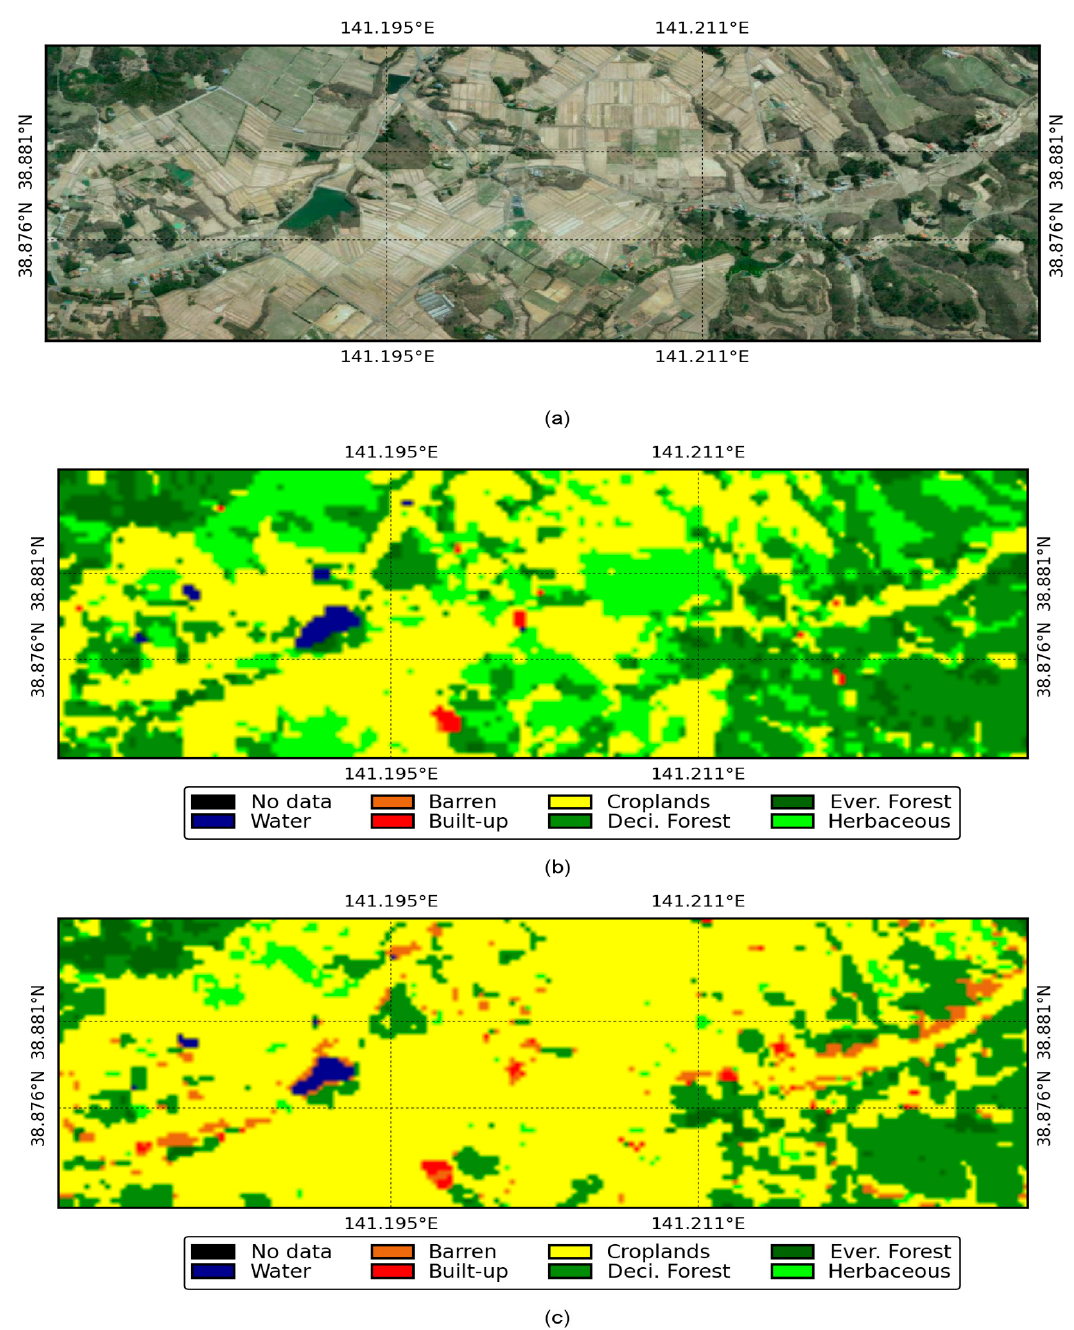
Figure 13. Performance of the JpLC-30 map over the JHR LULC map: ( a ) Google Earth™ image; ( b ) JHR LULC map; ( c ) JpLC-30 map.